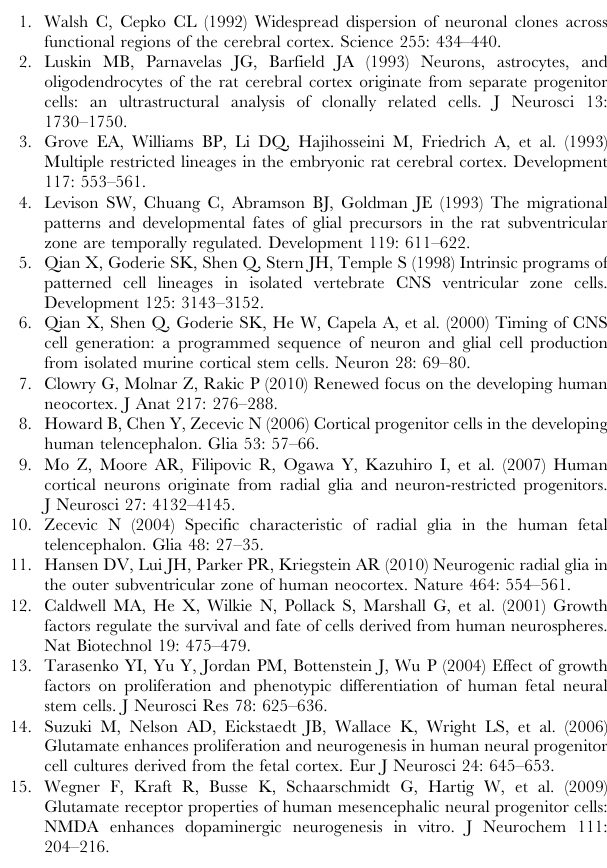
E16 mNSPCs shows that E12 cells are more neurogenic and E16 cells more gliogenic. Neuron and astrocyte counts were obtained from cells differentiated for 3 days (**p , 0.01, n= 250 or more cells from 3 separate experiments). Error bars represent s.e.m. (TIF) Figure S3 HuNSPC membrane capacitance does not consistently correlate with neurogenic potential. Graphs of specific membrane conductance (Gspec, S= Siemens) and neurogenic capacity of SC27 or SC23 cells (revealed by generation of MAP2-positive neurons) over increasing passage number demonstrate the lack of a clear correlation between these measures. Gspec values of SC27 cells begin high, drop lower, and increase again as the neurogenic potential decreases. SC23 cells display a similar decrease in neurogenic potential over increasing passage number but their Gspec values begin low, increase slightly, and increase again. Error bars represent s.e.m. and n= 3 or more separate experiments with different sets of cells.